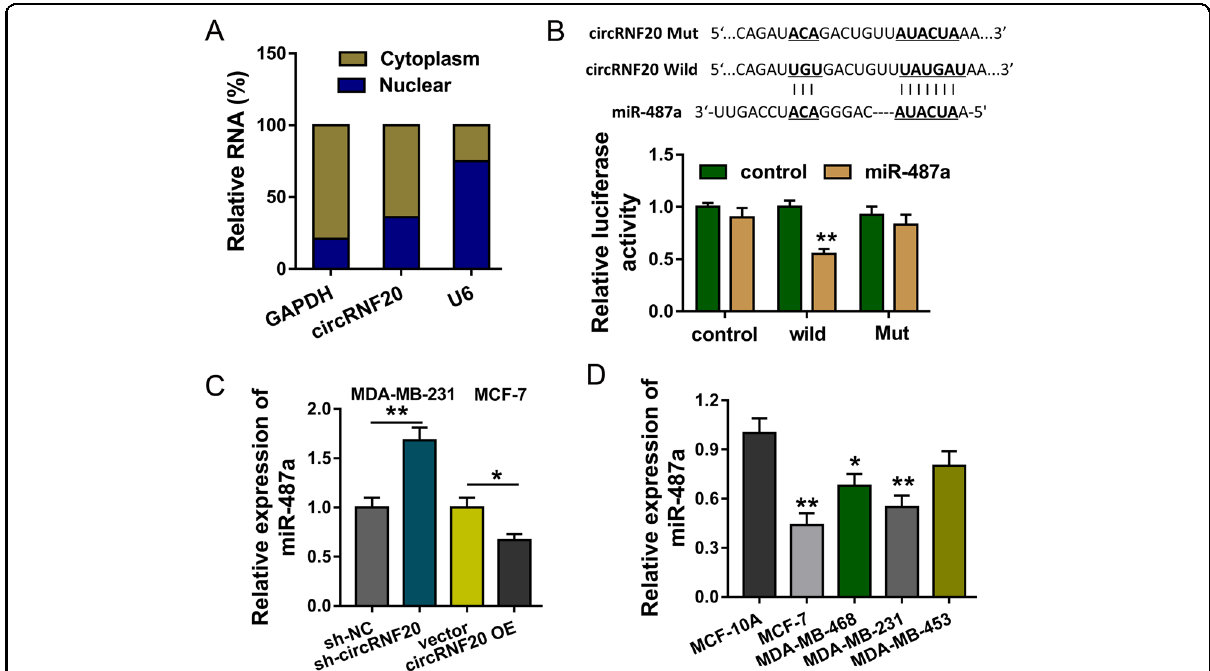
Fig. 3 circRNF20 acts as the sponge of miR-487a. a The subcellular location analysis indicated the distribution of circRNF20 in the cytoplasm and nucleus. b Complementary binding sites within circRNF20 and miR-487a were predicted using online bioinformatic prediction (CircInteractome, https://circinteractome.nia.nih.gov) and ENCORI (http://starbase.sysu.edu.cn/). Luciferase reporter assay indicated the combination of circRNF20 with miR-487a. c RT-PCR illustrated the miR-487a expression in BC cells (MDA-MB-231, MCF-7) with circRNF20 knockdown or circRNF20 overexpression. d RT-PCR showed the miR-487a level in the BC cell lines. ** p < 0.01 vs. control. * p < 0.05 vs.